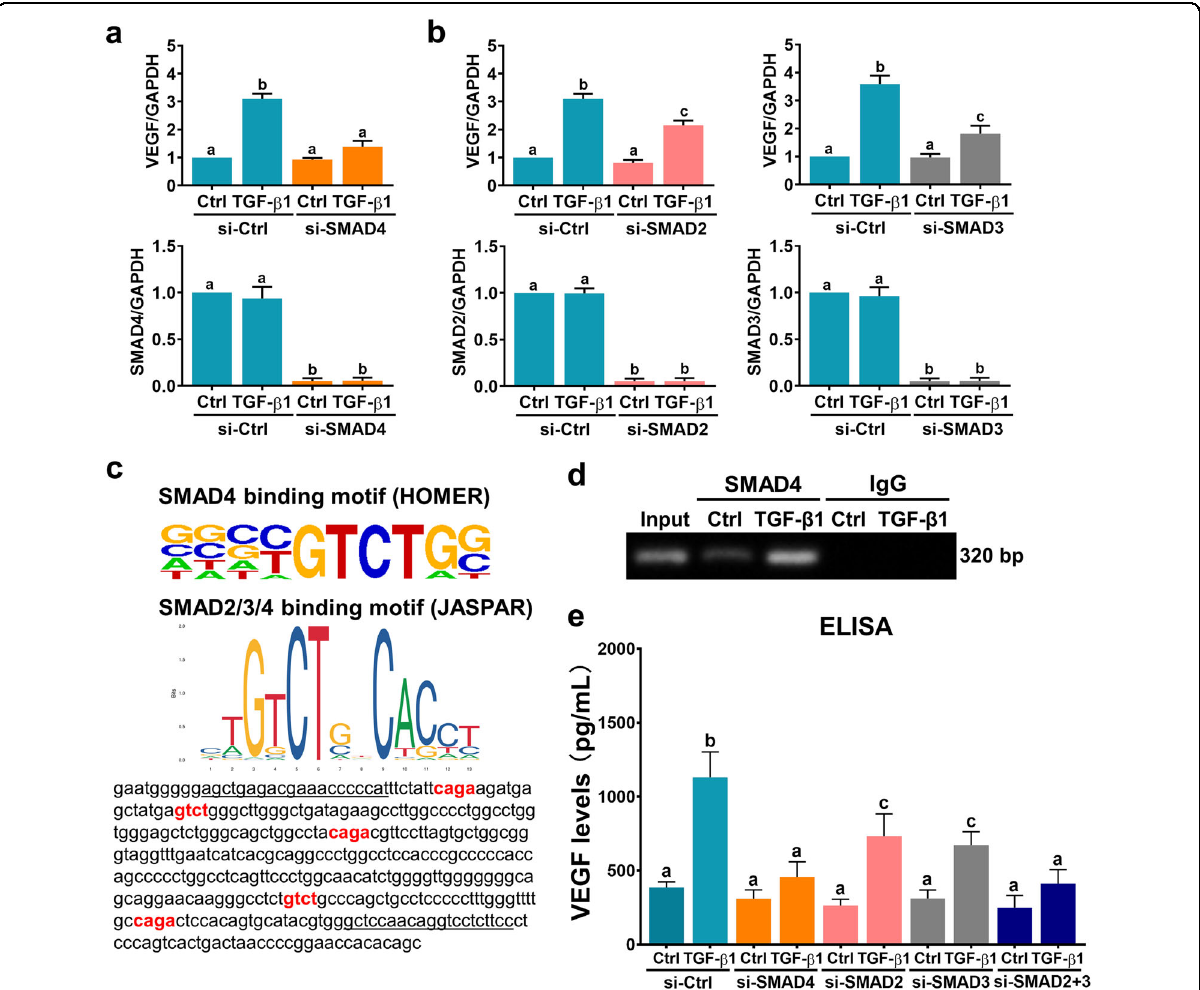
control siRNA (si-Ctrl) or SMAD4 siRNA (si-SMAD4), and after 48 h they were treated with 5 ng/mL TGF- β 1 for 6 h. VEGF and SMAD4 mRNA levels were examined by RT-qPCR. b SVOG cells were transfected with 50 nM control siRNA (si-Ctrl), SMAD2 siRNA (si-SMAD2) or SMAD3 siRNA (si-SMAD3),